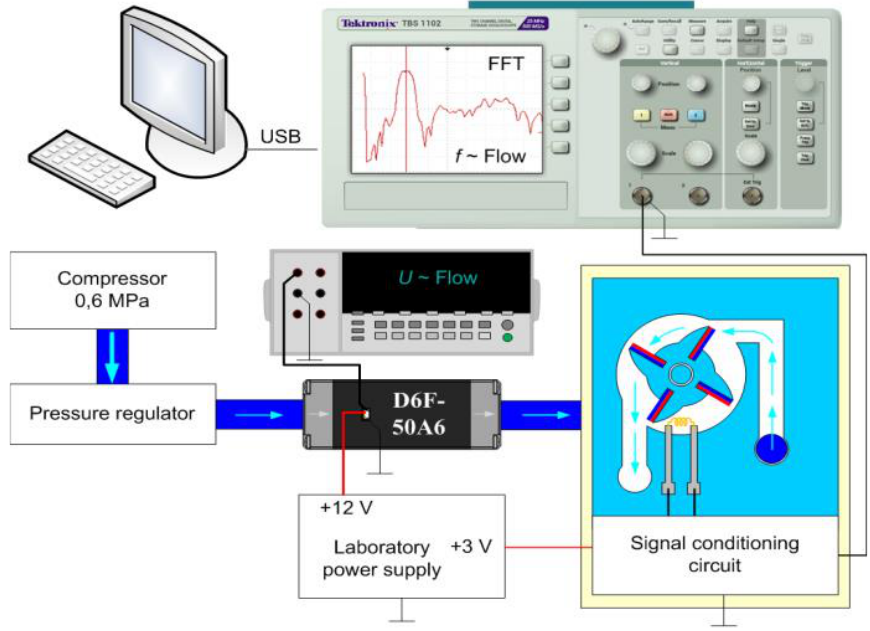
Figure 4. Block diagram of laboratory stand: D6F-50A6 is a reference flow meter. USB — Universal Serial Bus; FFT — Fast Fourier Transform; D6F-50A6 — flow-meter of fluid (OMRON, Warszawa, Poland); f — measured frequency; U — measured voltage.